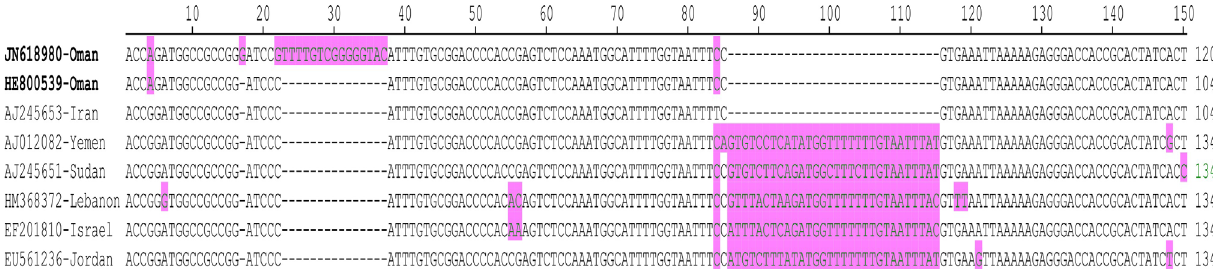
Figure 2. Alignment of CR sequences of the DNA B components of WmCSV from Oman and the database sequences from different origins. Spaces (-) are introduced to optimize the alignment. Differences in the sequences are highlighted. Oman isolates are marked as